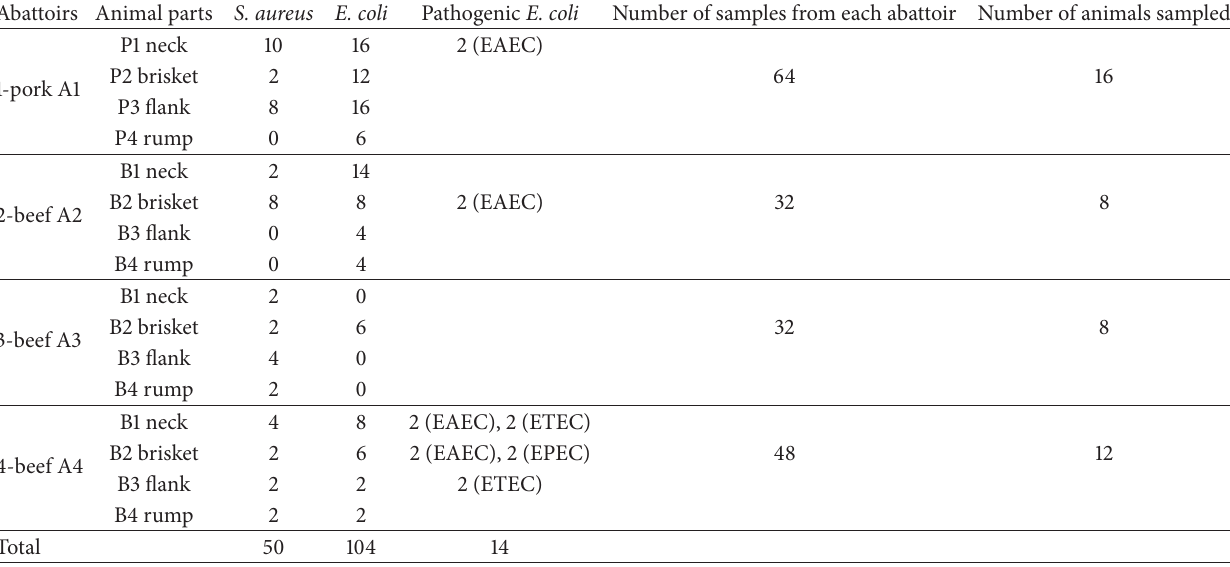
Table 2: Bacteria distribution in the different parts of cattle and pig carcasses examined in the various abattoirs. Abattoirs Animal parts S. aureus E. coli